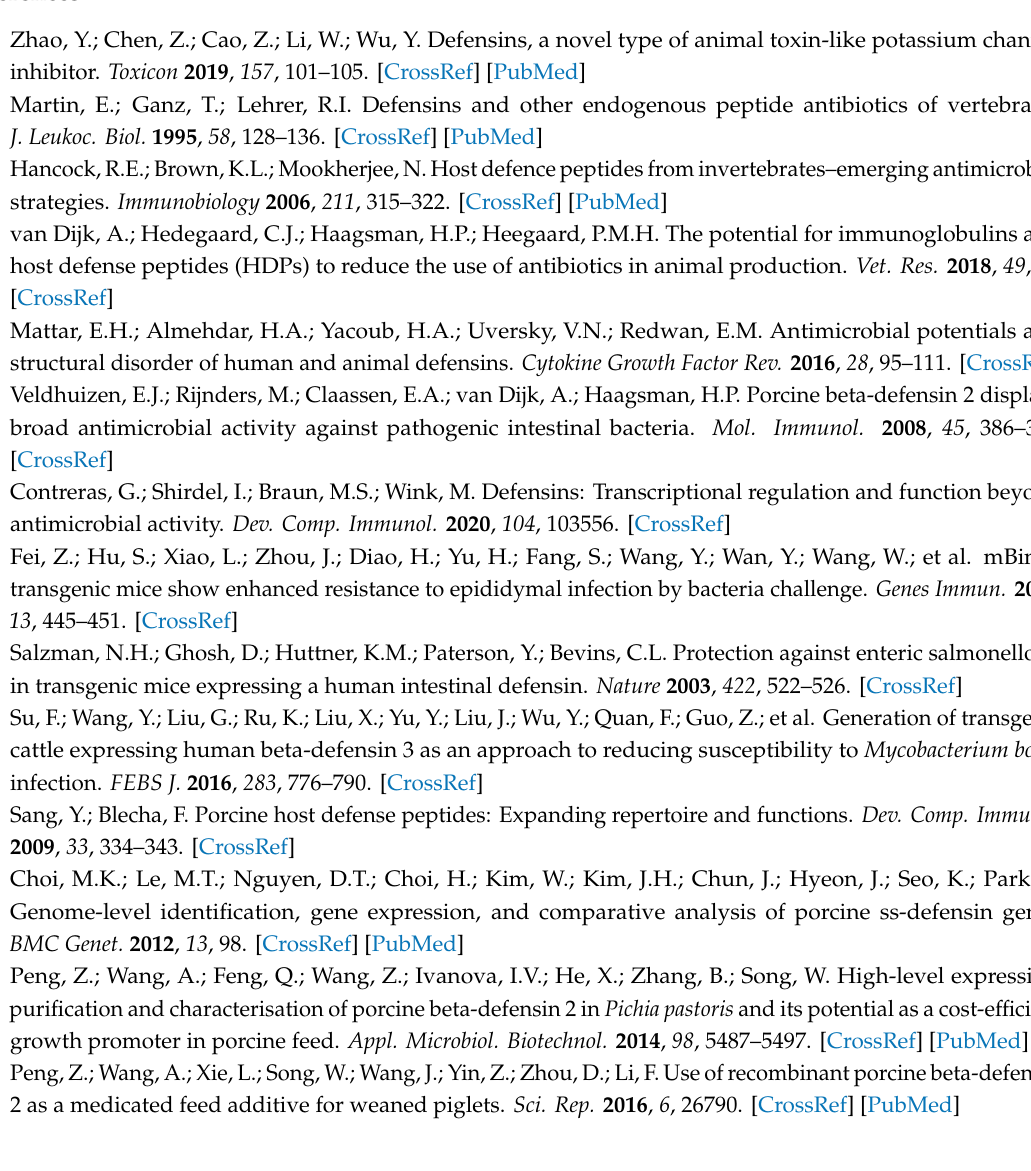
Figure S1: Bactericidal activity of porcine β -defensin 2 (PBD-2) against di ff erent Glaesserella parasuis serovars. Table S1: Score for clinical signs of pigs during cohabitation. Table S2: Score for macroscopic pathological changes after dissecting